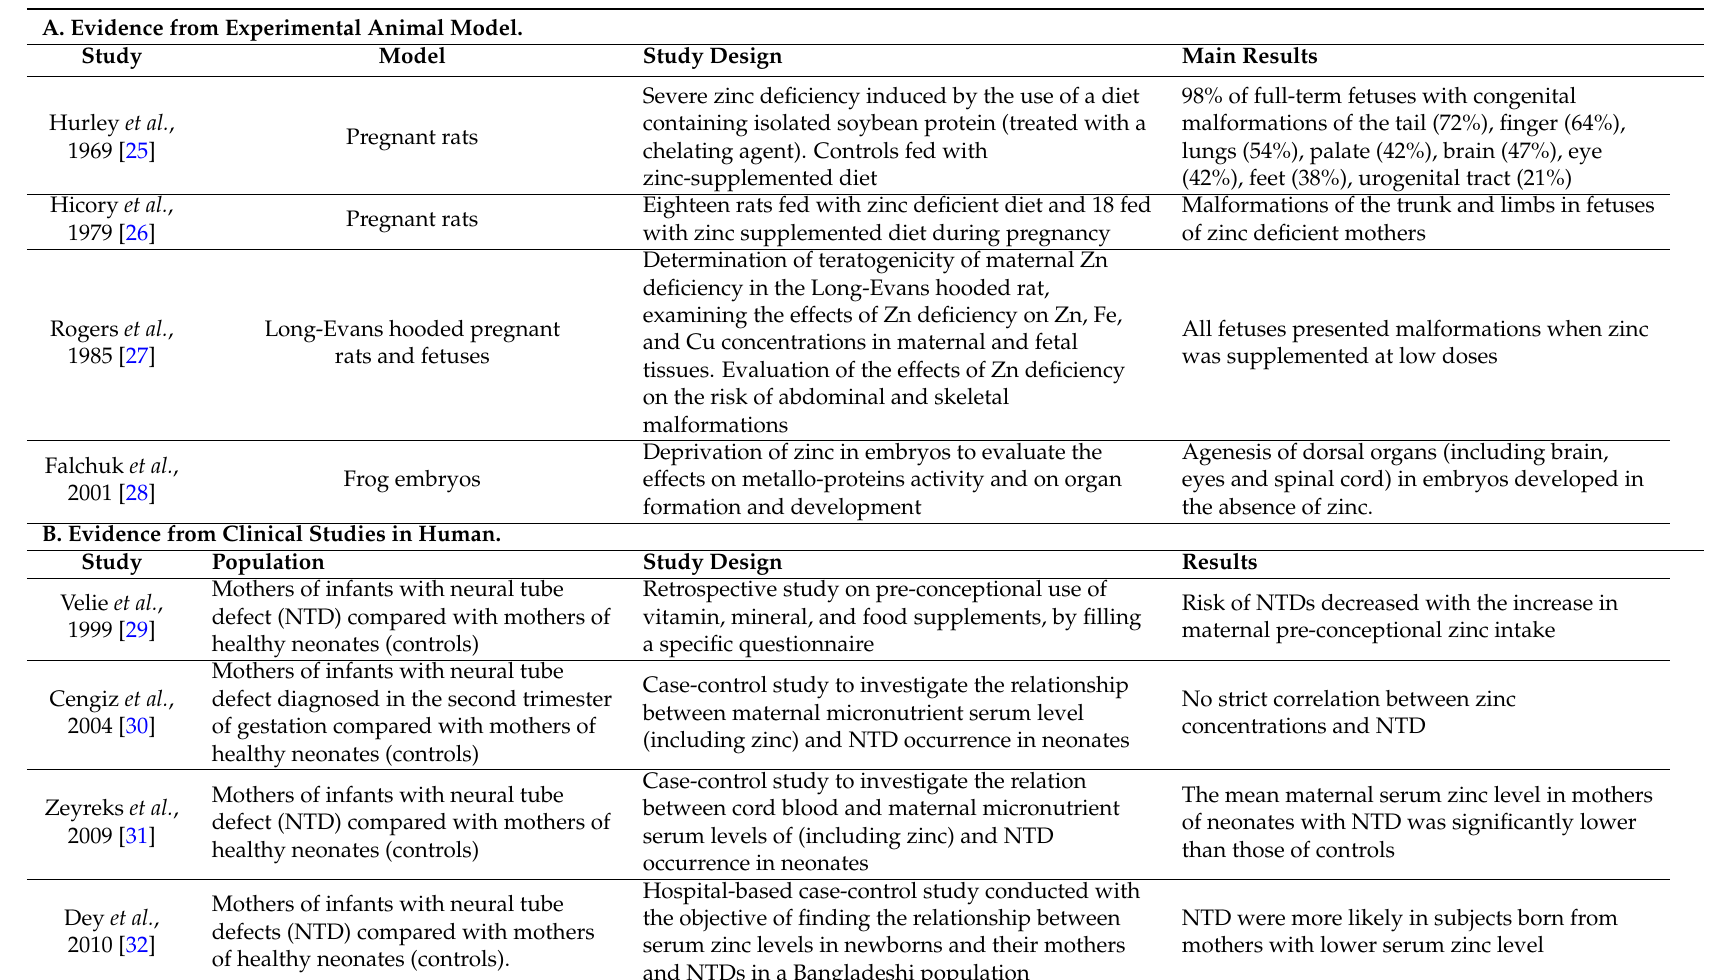
Table 2. The role of zinc in embryogenesis. Evidence from animal and human